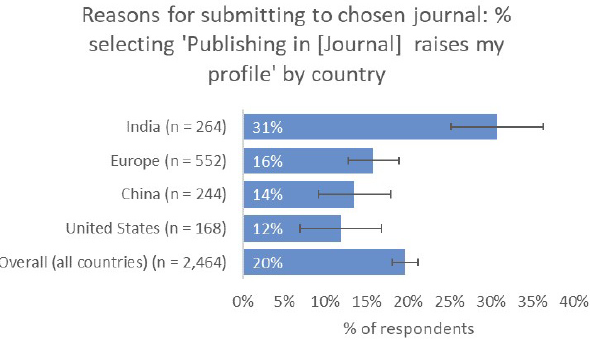
Figure 16. Relative importance of raising the respondent’s profile in determining choice of